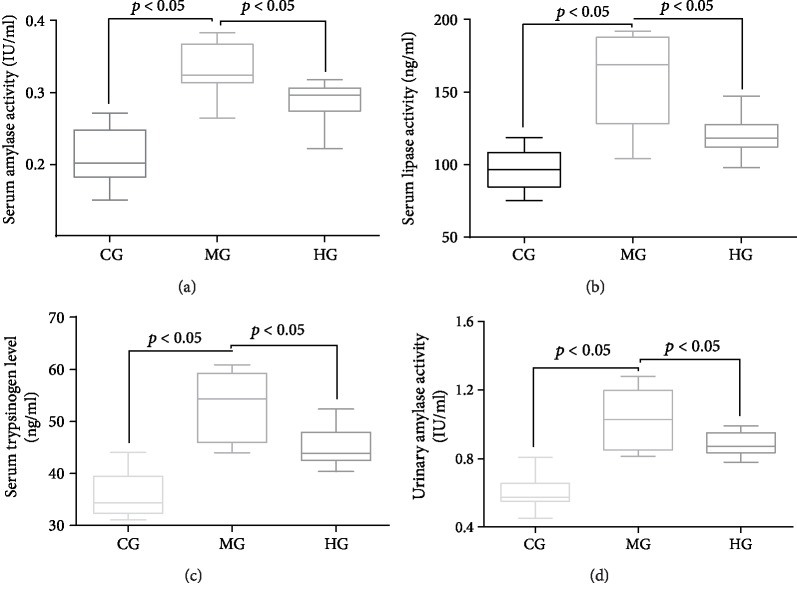
The levels of biomarkers in the diagnosis of pancreatitis among different groups. All data were presented as box plots with whiskers at the 10th percentile and 90th percentile, and the statistical difference was significant if p < 0.05.